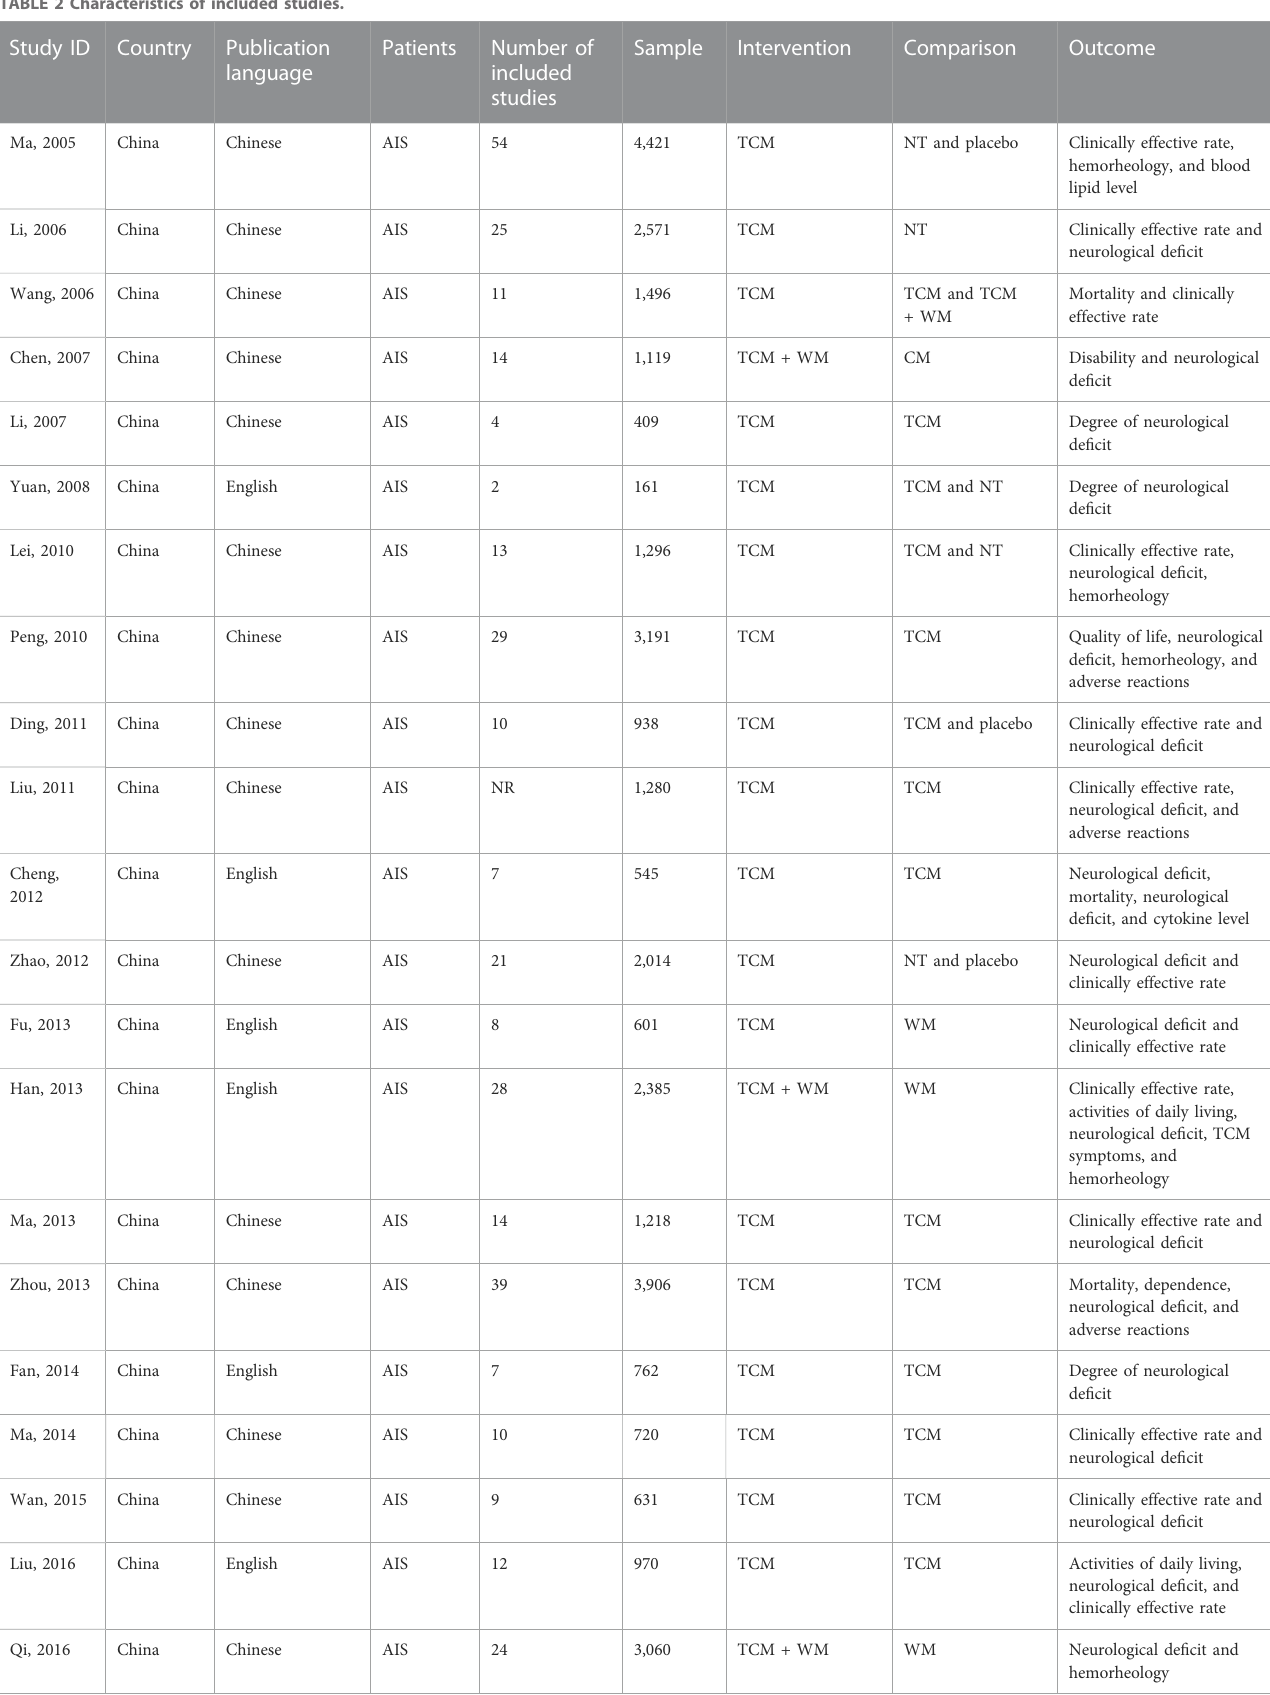
TABLE 2 Characteristics of included